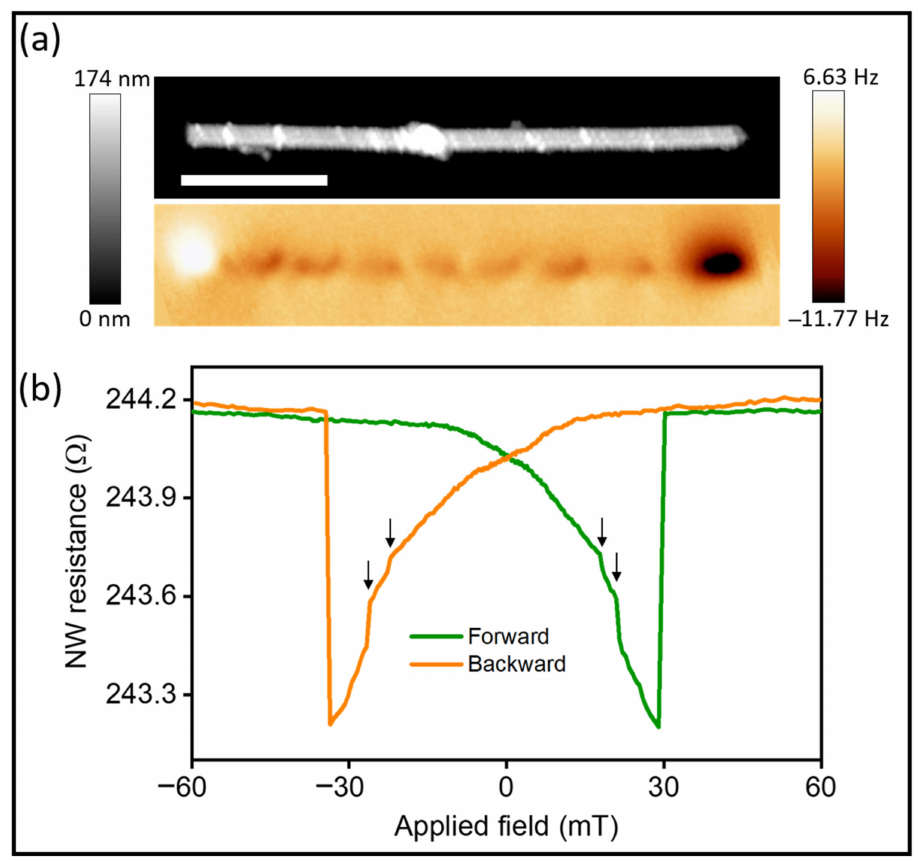
Figure 1. ( a ) AFM and ( b ) MFM image of an individual Co 85 Ni 15 /Cu nanowire. Scale bar = 2 µ m. ( b ) Magnetoresistance curves of a nanowire that is under a current of 0.5 mA. Forward direction corresponds to the field applied from − 60 to +60 mT, and backward from +60 to − 60 mT). Arrows indicate positions of some jumps in magnetization